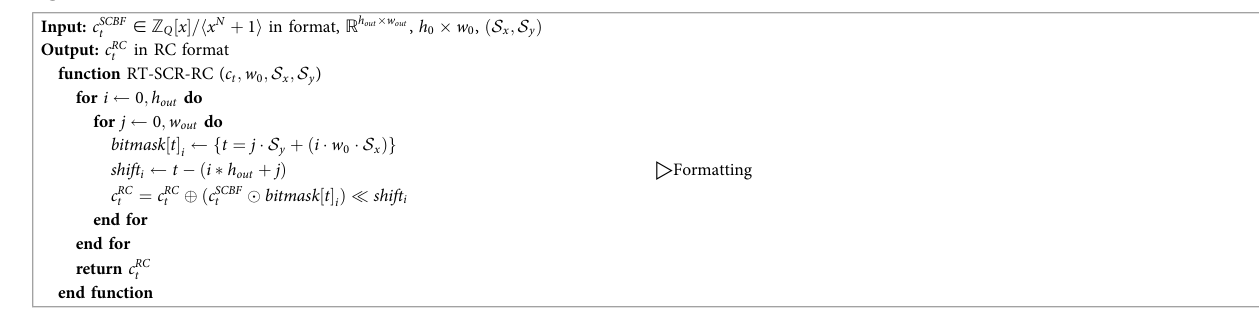
Algorithm 3 Streamlined Convolution Result Transformation